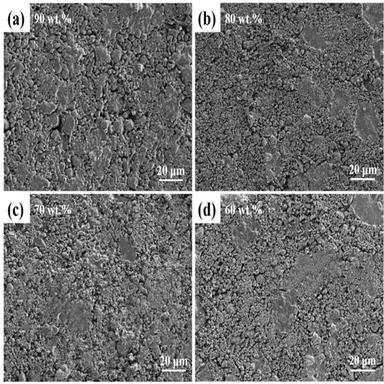
SEM micrographs of samples after sintering at 1200 ◦C with different pretreated steel slag contents.